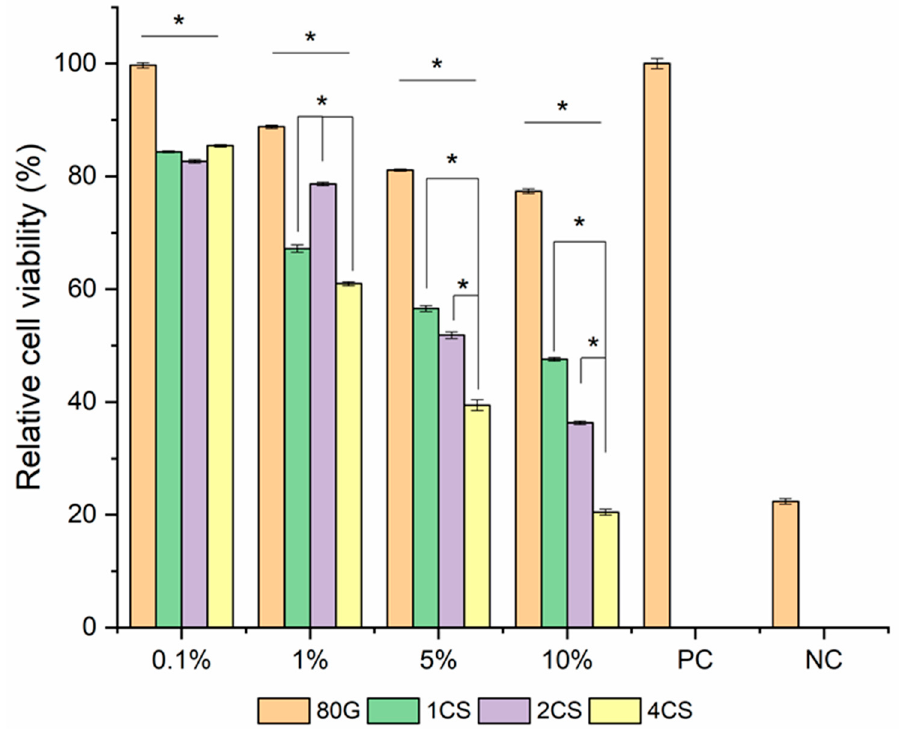
Figure 9. Relative cell viability percentage of MG-63 cells cultured with 0.1, 1, 5 and 10 wt./vol.% extract of MBG (n = 9, PC = positive control, NC = Negative control, samples in triplicate, * p < 0.05).